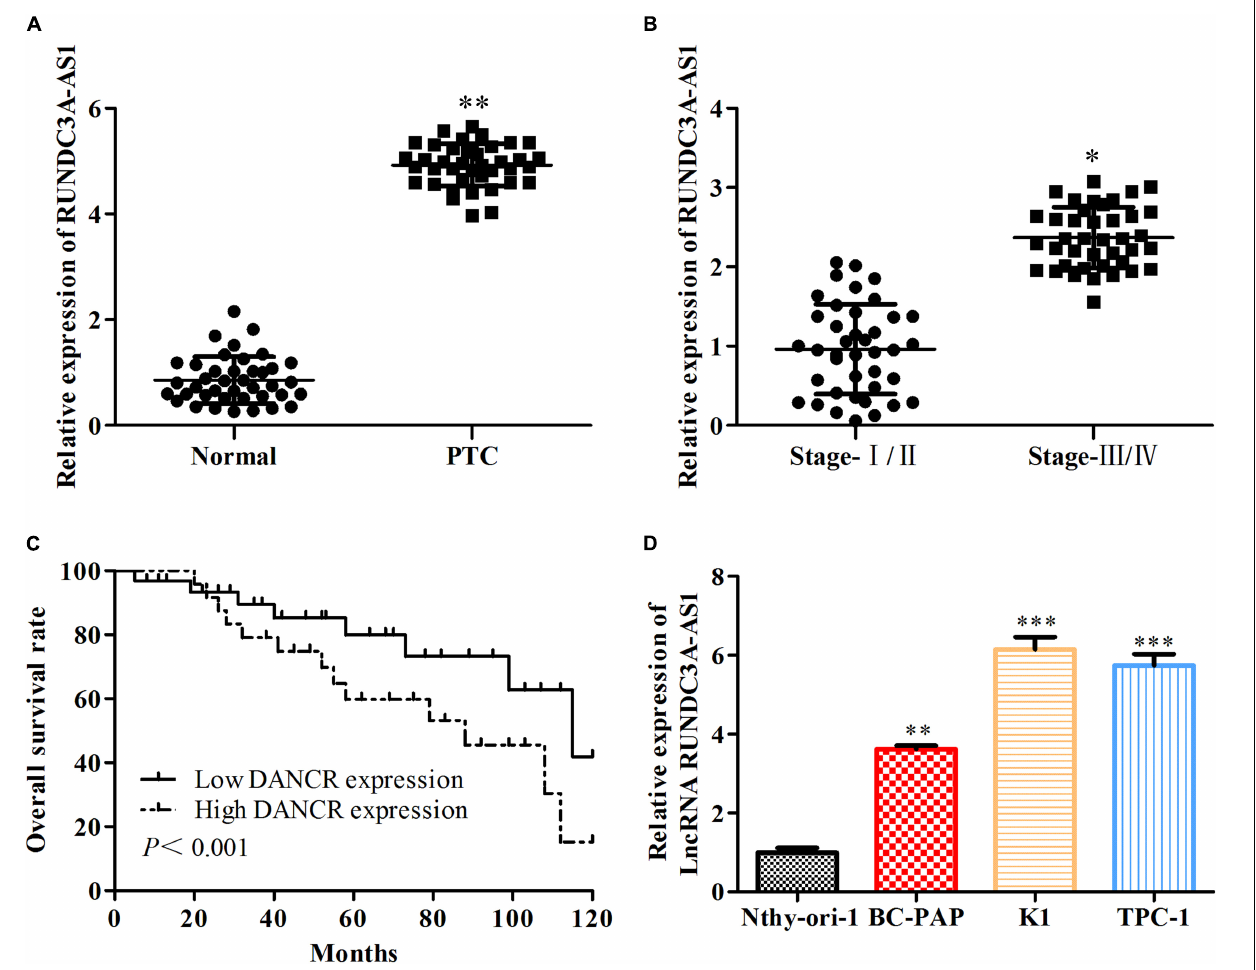
FIGURE 1 | The expression level of RUNDC3A-AS1 is upregulated both in thyroid cancer tissue and its cell lines. (A) The expression level of lncRNA RUNDC3A-AS1 in tumor and para-carcinoma tissues. ** P < 0.01 vs. the normal tissue. (B) The relationship between expression of lncRNA RUNDC3A-AS1 and different TNM stages of thyroid cancer.* P < 0.05, vs. the normal tissue. (C) The relationship between expression of lncRNA RUNDC3A-AS1 and overall survival of thyroid cancer patients in TGGA database. (D) The expression level of lncRNA RUNDC3A-AS1 in normal thyroid cells and thyroid cancer cell lines. ** P < 0.01, *** P < 0.005 vs. the Nthy-ori3-1 cell line. The data were presented as mean ± SD and the experiments were repeated 3